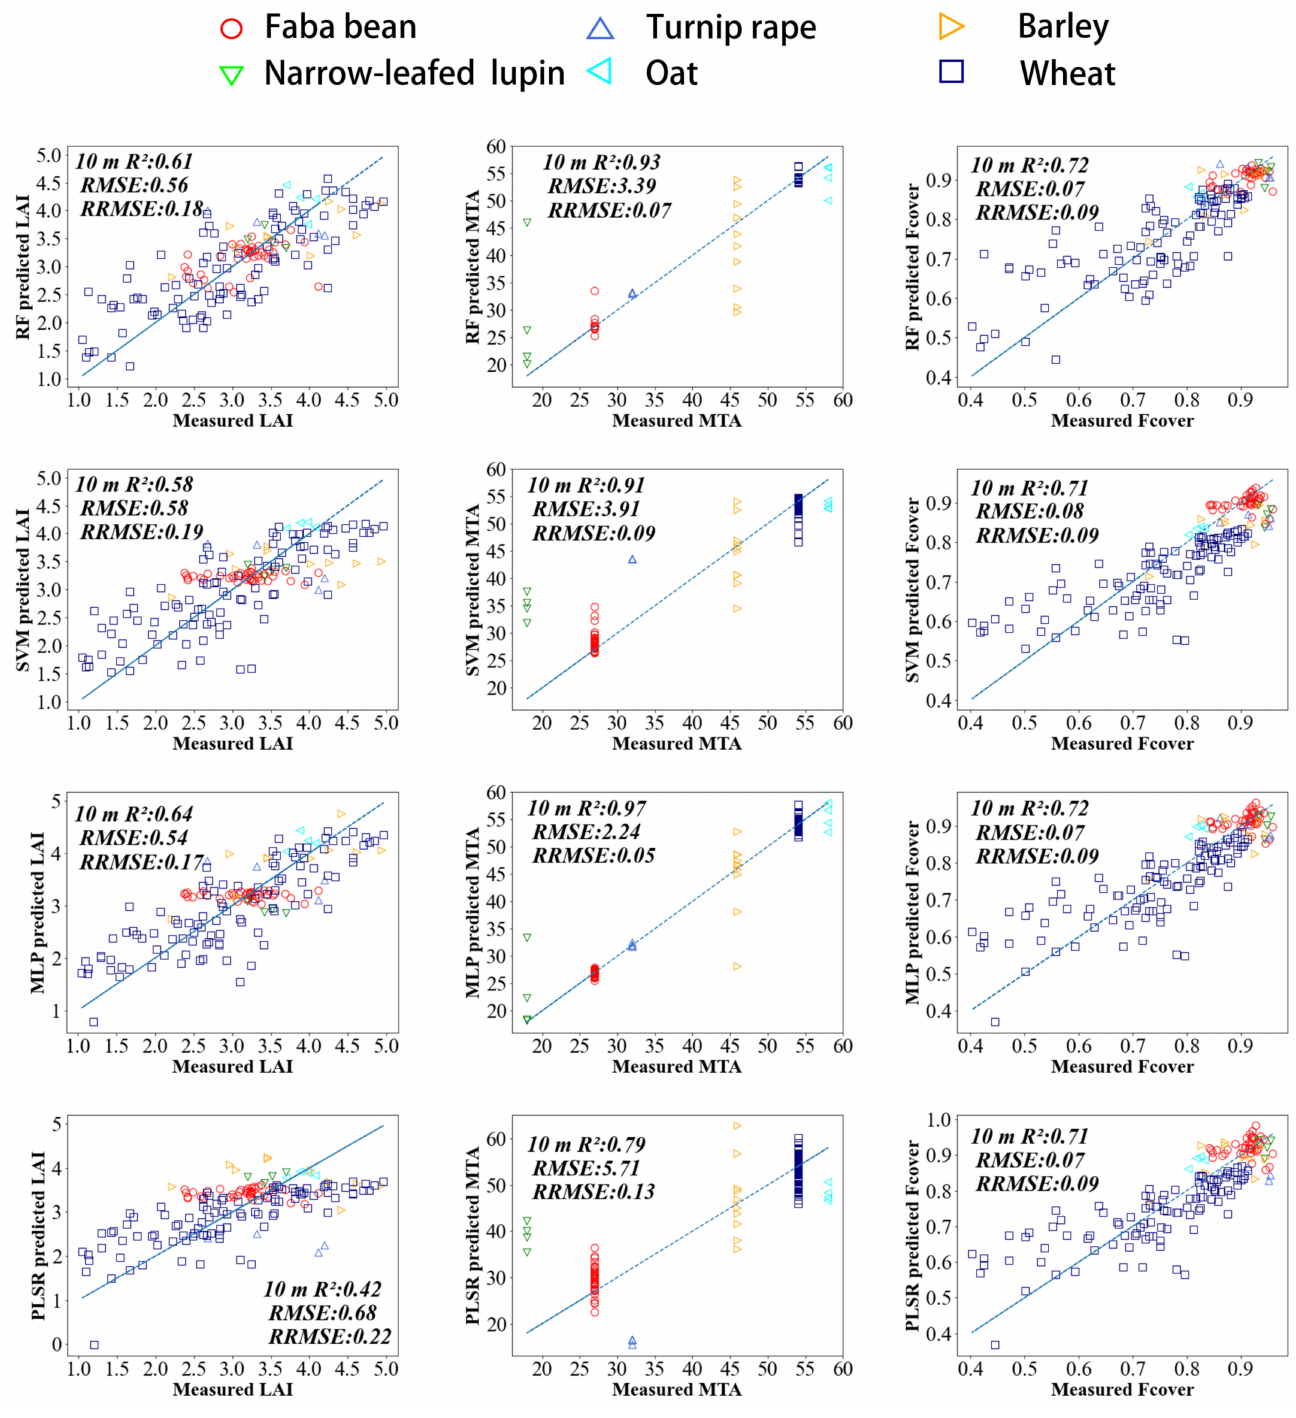
Figure 4. Canopy structure parameters estimated using simulated Sentinel-2 bands which have 10 m resolution in field-measured